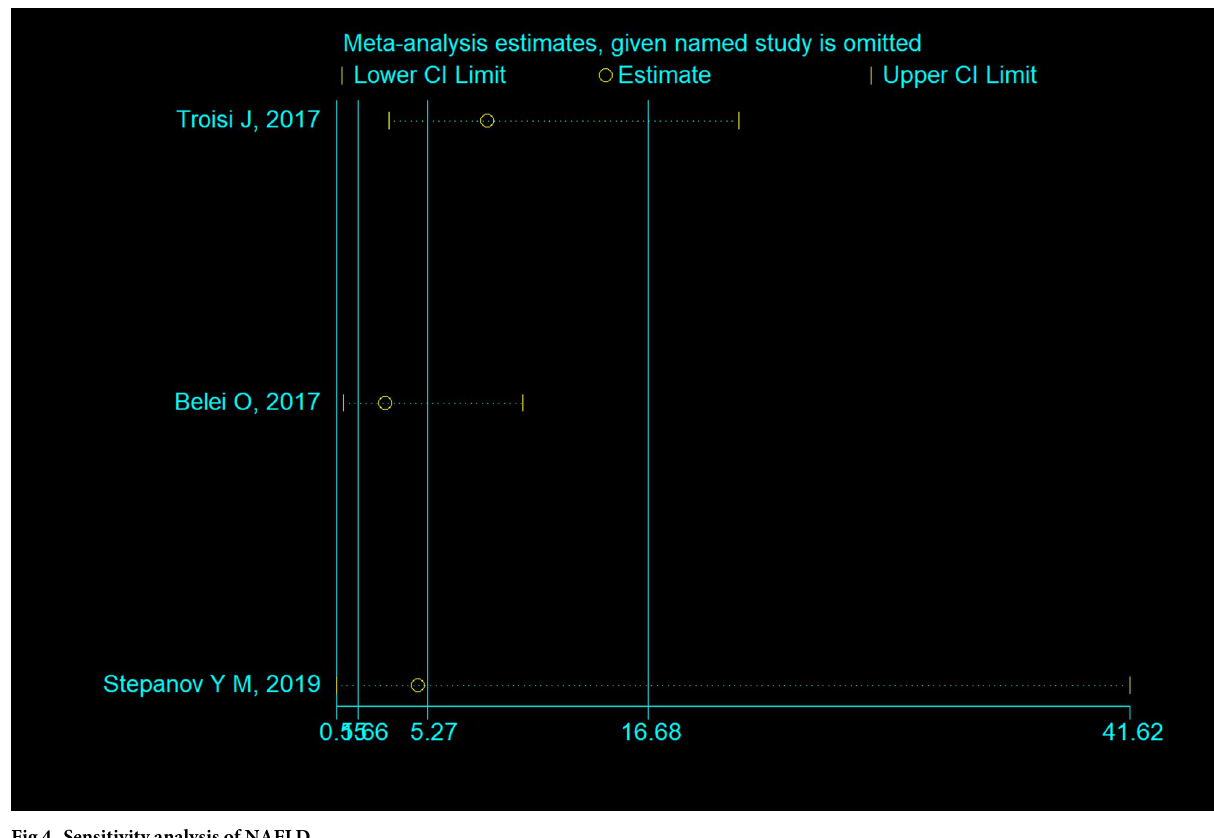
Fig 4. Sensitivity analysis of